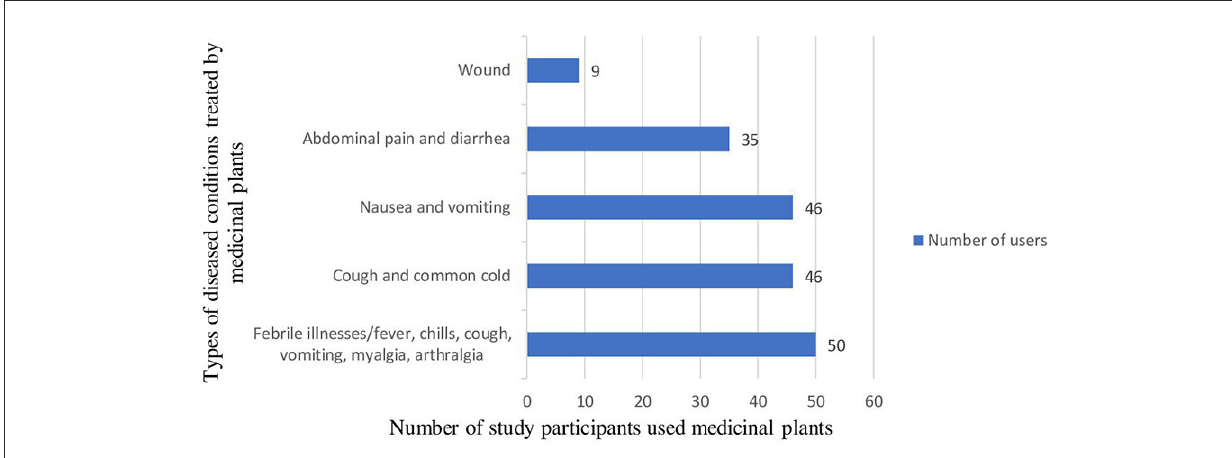
FIGURE2 Diseased conditions treated by the study participants using medicinal plants in East Gojjam Zone, Northwest Ethiopia, 2021 ( N =